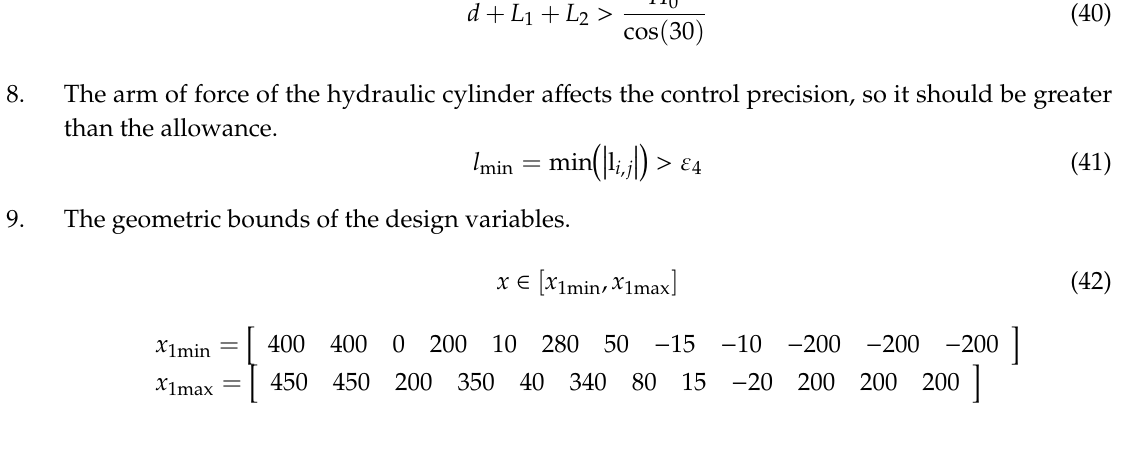
The geometric bounds of the design